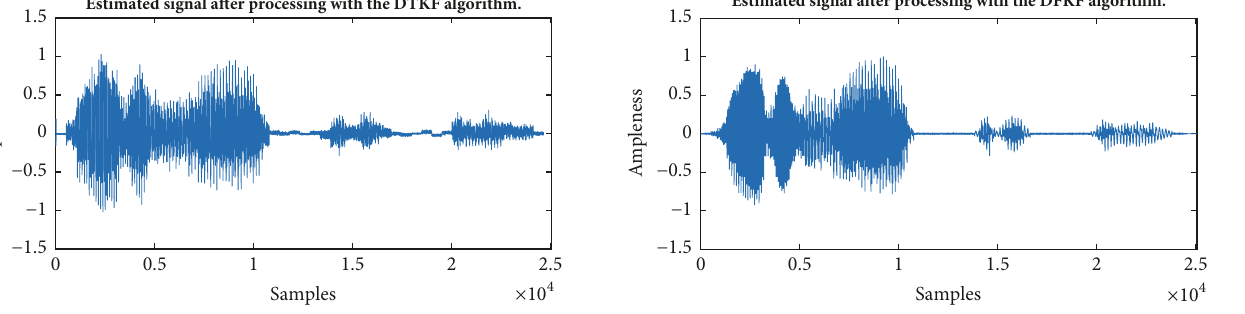
Figure 5: Estimated signal after processing with the DFKF algo- rithm.